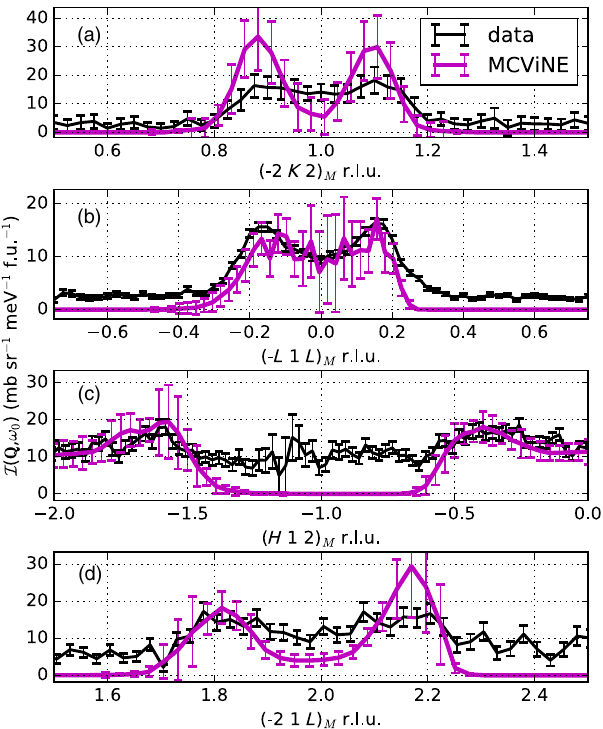
FIG. 11. Constant energy cuts at ℏ ω 0 ¼ 30 meV (averaging range = [29,31] meV) through the experimental data for ð V Þ 0 . 96 Cr 0 . 04 2 O 3 at 5 K [Fig. 3(c)] and the corresponding MCV I NE simulation (Fig.